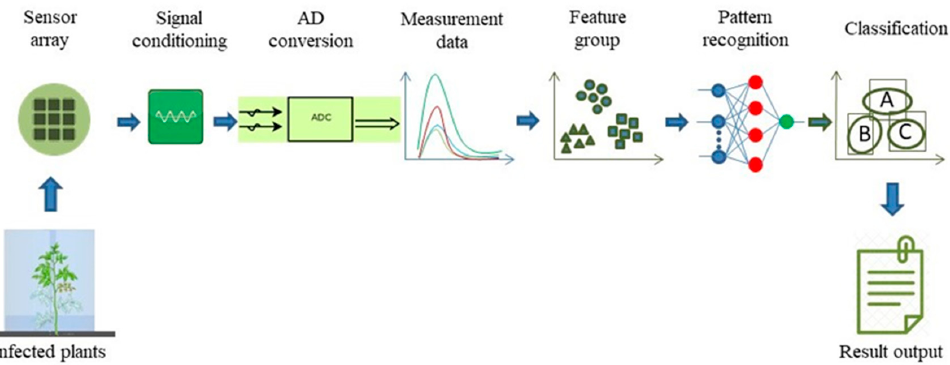
Figure 4. Process chart for diagnosing plant diseases and pests using the electronic nose.